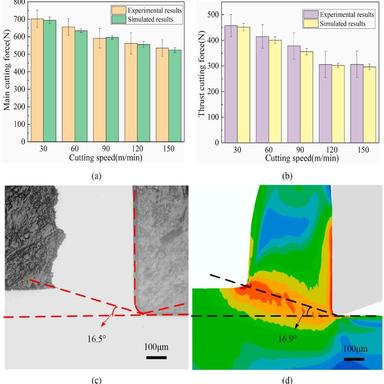
Comparison of cutting forces and shear angle between the simulation and experimental results. (a) and (b) present the comparison of the main cutting forces and thrust cutting forces at different cutting speeds. (c) and (d) present the chip roots by the experimental and simulation results, in which the shear angles were measured. The error bars represent the highest and lowest cutting force during simulation and experiments in Fig. 17a and b.